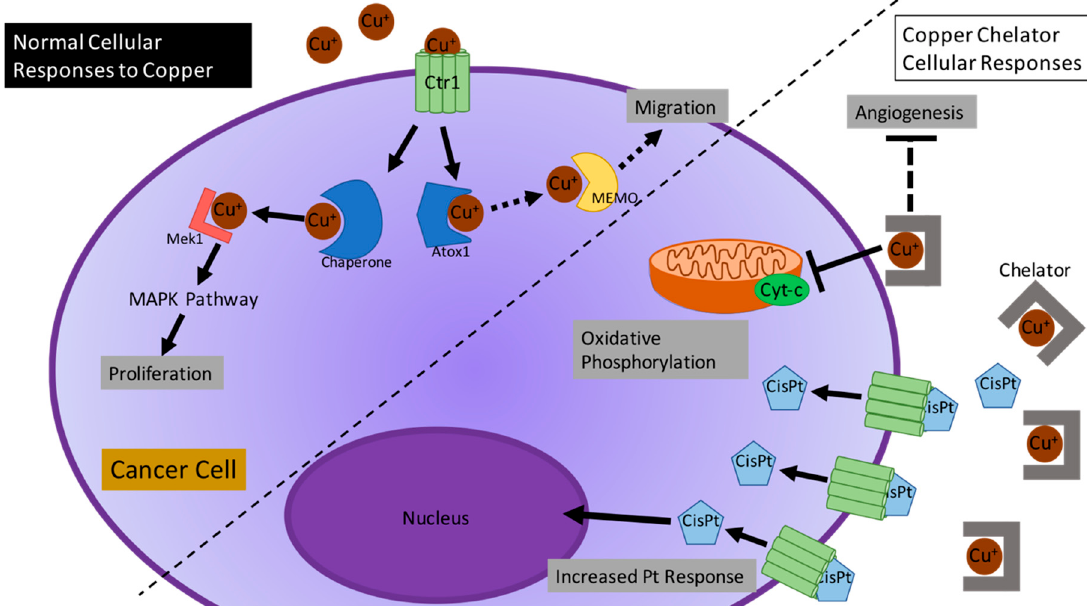
Figure 1. Normal cellular responses to Cu and altered cellular responses with Cu chelator treatment in cancer cells. Once Cu(II) is reduced to Cu(I), it can enter the cell through the high-affinity Cu transporter Ctr1. Cu(I) can be bound to Cu chaperones and transported in the cytoplasm to several organelles, not shown here [14,23,24]. Cu can be delivered to many Cu-binding proteins, including Mek1 and MEMO. Mek1, when activated by Cu binding, will activate the MAPK pathway, which leads to cell proliferation. Antioxidant 1 Cu chaperone (ATOX1) mediates the delivery of Cu to Cu-binding proteins located in the lamellipodia (not shown here), such as MEMO, which is separately known to regulate cancer cell migration and could have implications in metastasis [12,24]. Cu has been associated with angiogenesis [23]. Cu chelator tetrathiomolybdate (TM) treatment can delay the activation of angiogenesis on pancreatic islets. In pancreatic neuroendocrine tumor cells, treatment with TM reduced the activity of Cyt-c, which results in decreased oxidative phosphorylation [23]. CisPt can enter cancer cells through Ctr1. When Cu is present in high levels (a common property of many cancers) cells downregulate the expression of Ctr1 [12]. This results in less CisPt entering the cells. Here, we show the use of Cu chelators to overcome CisPt resistance and make cancer cells more sensitive to this chemotherapeutic agent [12,14,15,23–25].